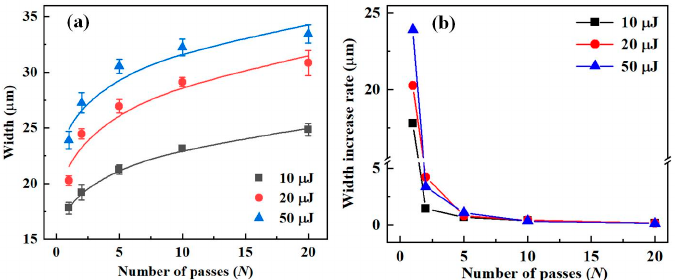
Figure 7. The width of the microgroove relative to N at a scanning speed of 50 mm/s. ( a ) The width and ( b ) width increase rate vary with the number of passes. and ( b ) width increase rate vary with the number of